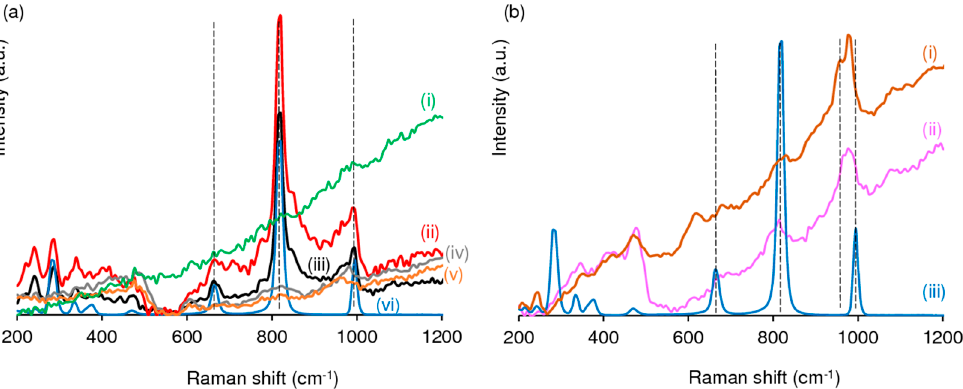
Figure 7. Raman spectra of ( a ) TUD-1(PT) ((i)-green), Mo-TUD(IWI-ahm) ((ii)-red), Mo-TUD(HT) ((iii)-black), Mo-TUD(IWI-acac) ((iv)-grey), Mo-TUD(IWI-amm) ((v)-orange), and bulk MoO 3 ((vi)- blue); and ( b ) Mo-hierBEA ((i)-brown), hierBEA ((ii)-pink) and bulk MoO 3 ((iii)-blue).